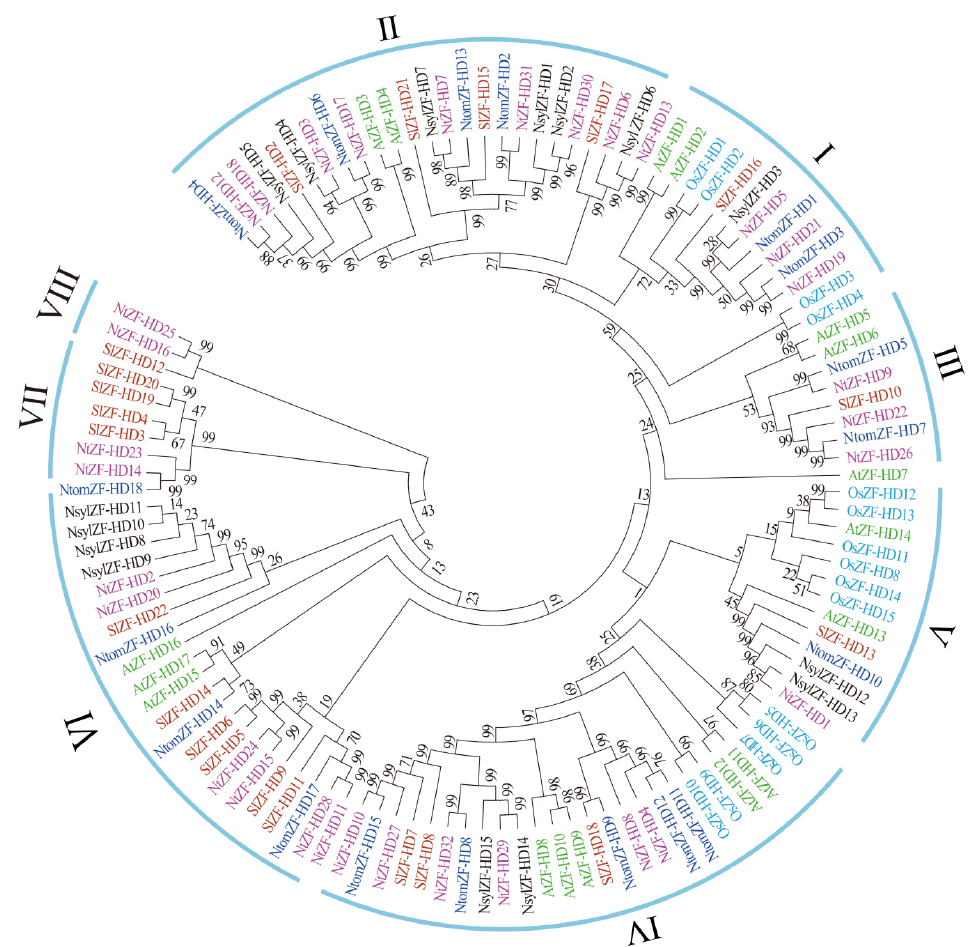
Figure 1. Phylogenetic relationship of Arabidopsis (AtZF-HD), tomato (SlZF-HD), rice (OsZF-HD), N. sylvestris (NsylZF-HD), N. tomentosiformis (NtomZF-HD), and tobacco (NtZF-HD) ZF-HD members, divided into six groups. The phylogenetic tree was generated using MEGA7 with the neighbor-joining method. The number of bootstrap values was set to 1000 replications. ZF-HD: Zinc finger homeodomain.